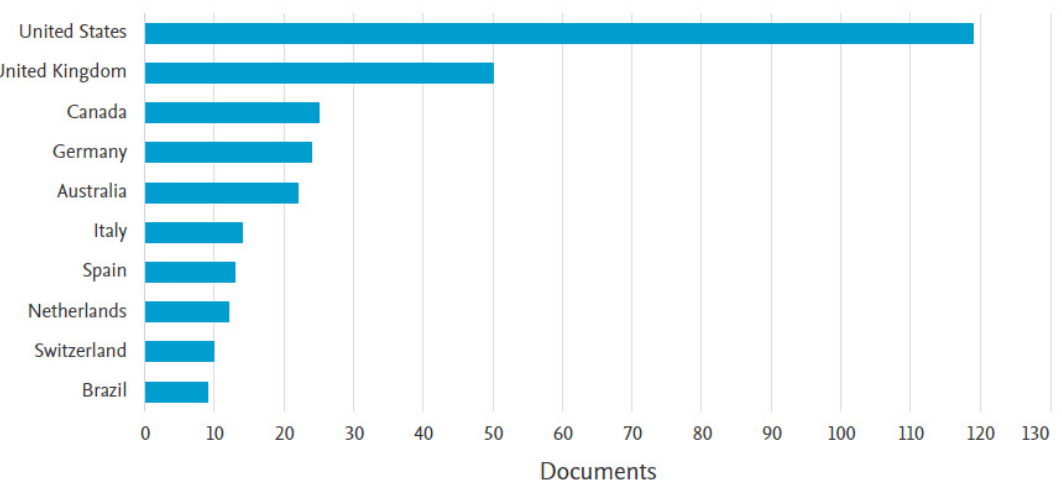
Figure 5. Top ten publishing countries.